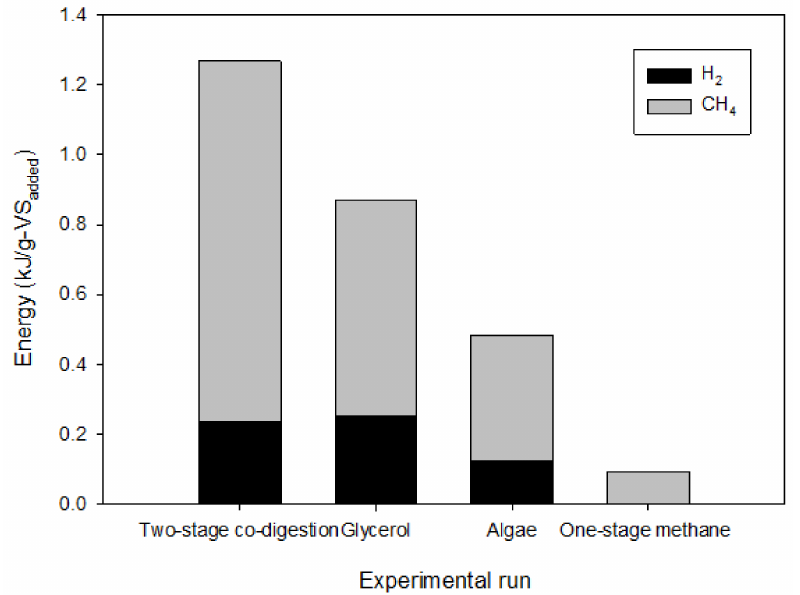
Figure 6. Energy production in two-stage hydrogen and methane production from the codigestion of crude glycerol and algal biomass and mono digestion of crude glycerol or algal biomass and one-stage methane production from the codigestion of crude glycerol and algal biomass [18]. Under the optimal conditions, the energy balance was calculated by subtracting output energy from input energy. At the optimum condition, the output energy was 38.38 kJ. Under these conditions, the substrate concentration and fermentation times were 30.22 g-VS added and 294 h, respectively. As a result, the input energy calculated based on Equation (7) was 5253 kJ. Hence, the net energy in two-stage hydrogen and methane production from a codigestion of crude glycerol with algal biomass was—5215 kJ. The high energy demand of the shaker (150 watt) was the main contributors to the high energy input, which resulted in negative net energy. An alternative low shaker consumption can be used to reduce the consumption of energy, making the process more energy